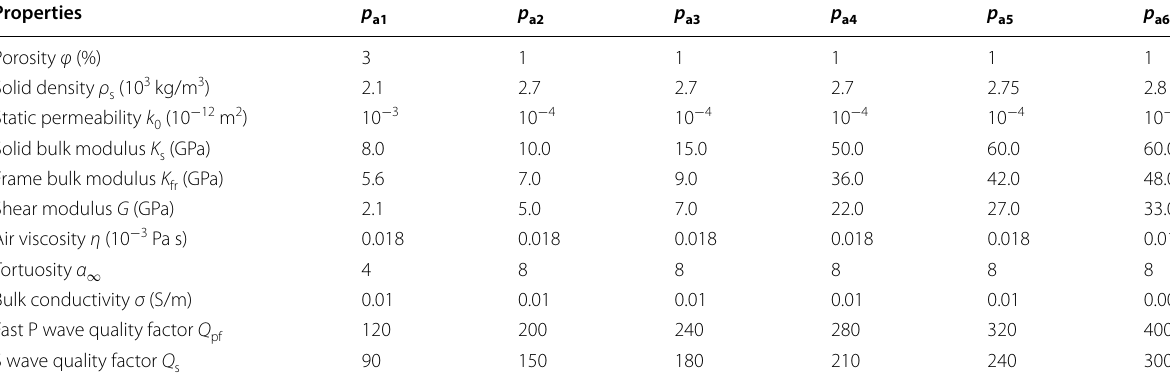
Table 2 Properties of the used air-saturated porous materials